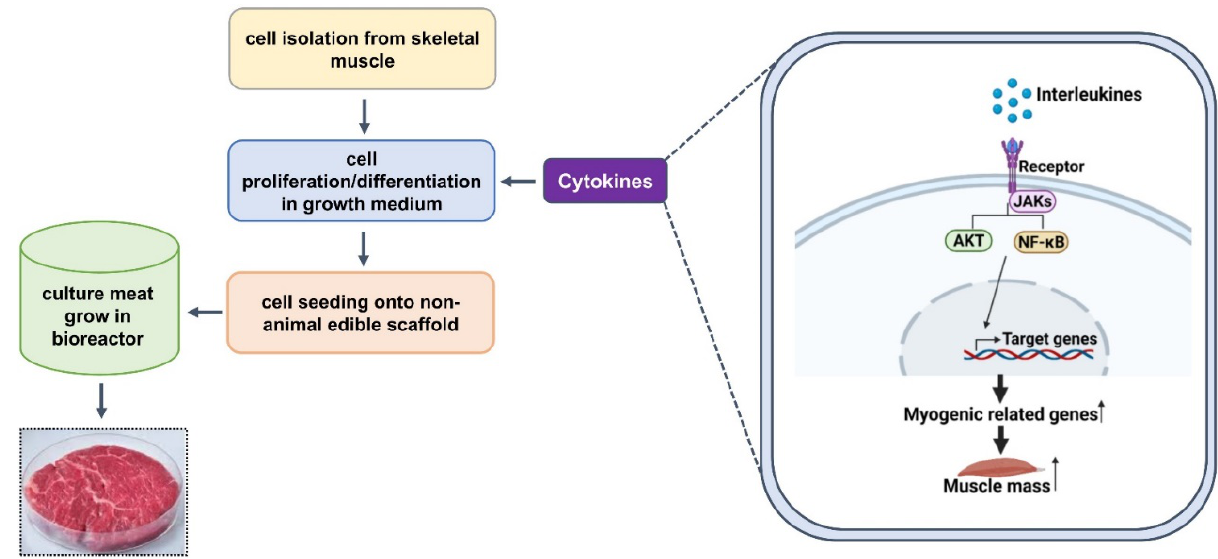
Figure 2. The cultured meat production process and the putative roles of myokines.